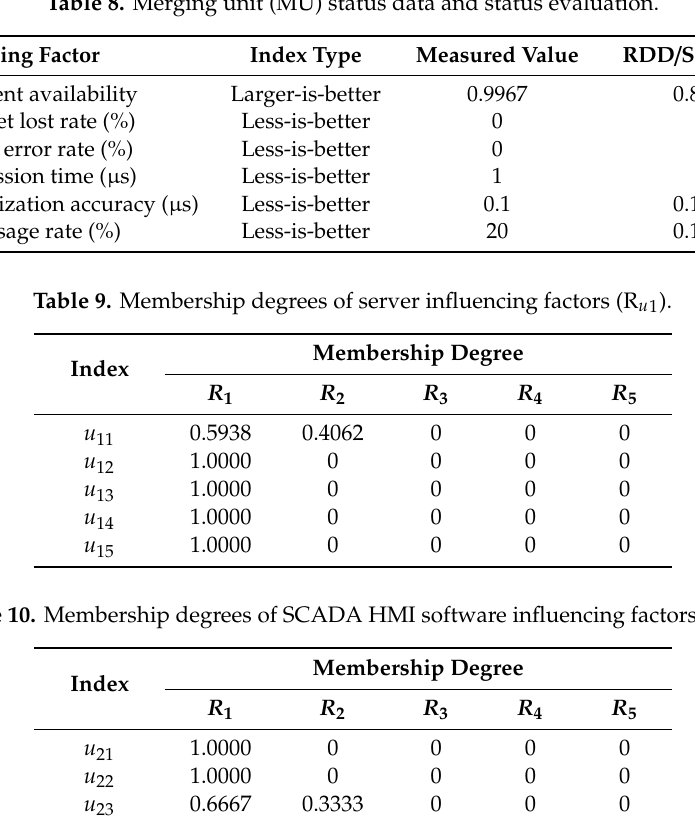
Table 8. Merging unit (MU) status data and status evaluation.